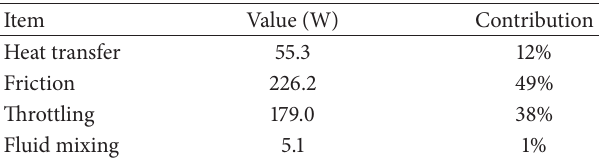
Table 2: Breakdown of average exergy destruction rate of the RV engine.